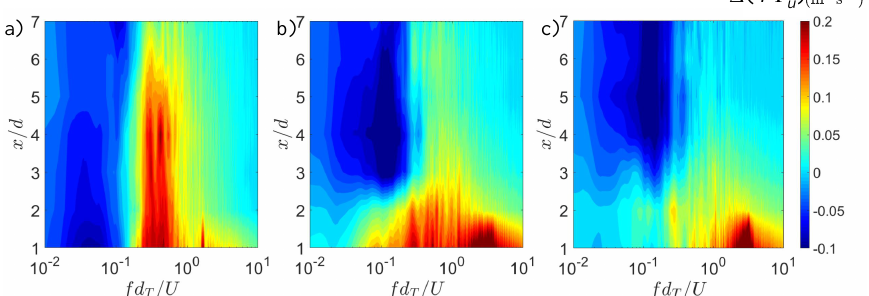
Figure 12. Difference of the compensated velocity spectra ∆ ( f Φ ) between the wake and incoming flow for the L / R = ( a ) 1, ( b ) 0.7 and ( c ) 0.6 rotors at the central plane of the wake within x / d T ≤ 7.